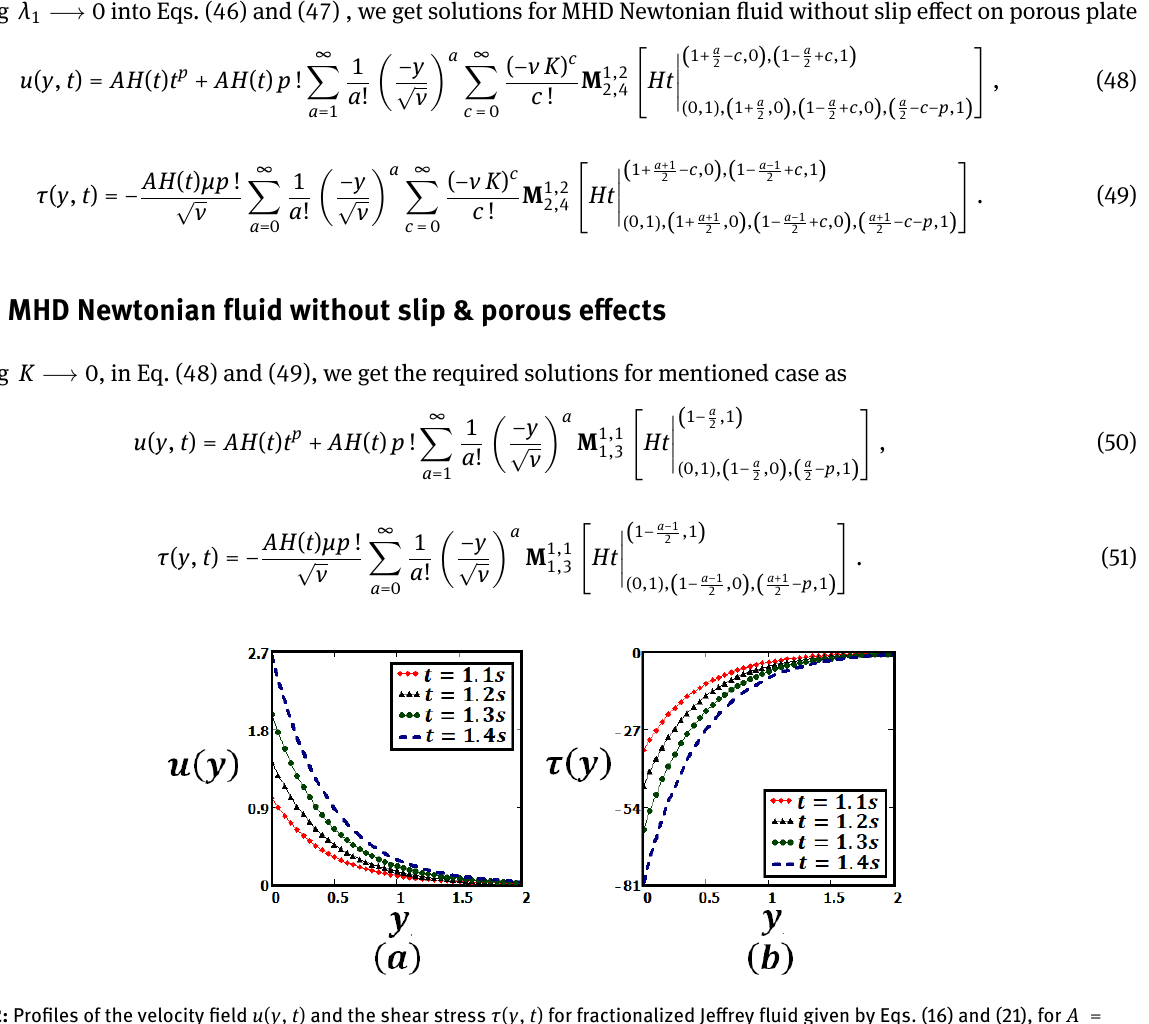
Figure 2: Profiles of the velocity field u ( y , t ) and the shear stress τ ( y , t ) for fractionalized Jeffrey fluid given by Eqs. (16) and (21), for A =